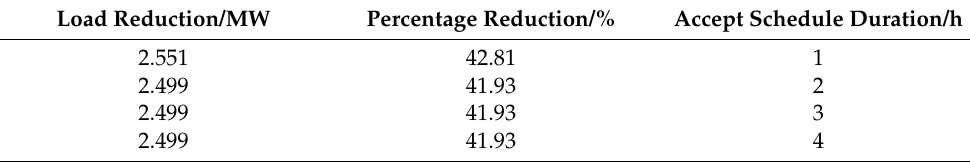
Table 2. Power reduction of inverter air conditioner cluster under different control